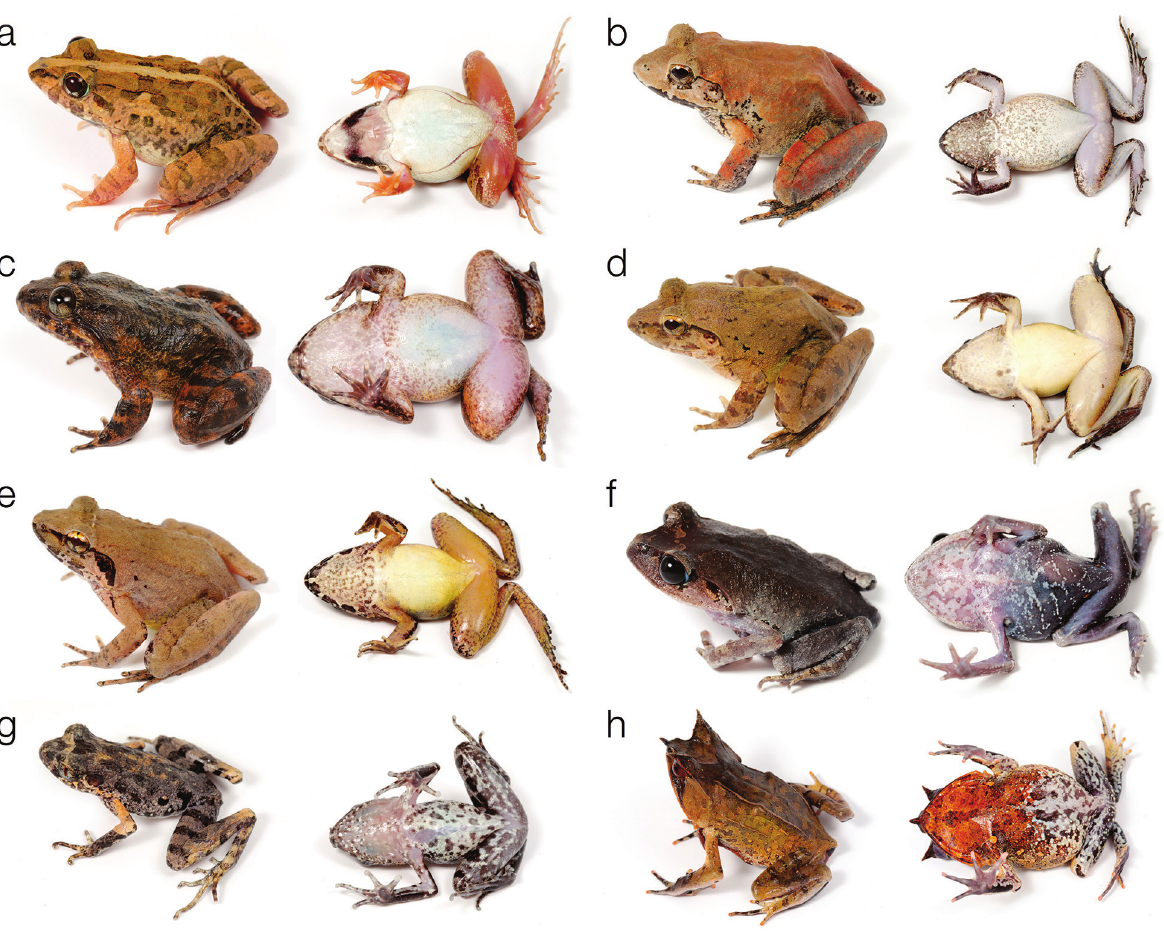
Figure 2. Frogs of the Dicroglossidae and Megophryidae at MBCA: a , Fejervarya limnocharis ; b , Limnonectes ingeri ; c , L. kuhlii ; d , L. leporinus ; e , L. paramacrodon ; f , Leptobrachium abbotti ; g , Leptolalax fritinniens ; h , Megophrys nasuta . Images not to scale. Pairs of photos (dorsolateral and ventral) depict the same